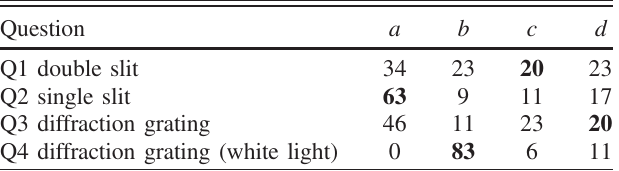
TABLE I. The percentages of students that selected a particular choice ( a , b , c , d ) for each question. The correct answer is in